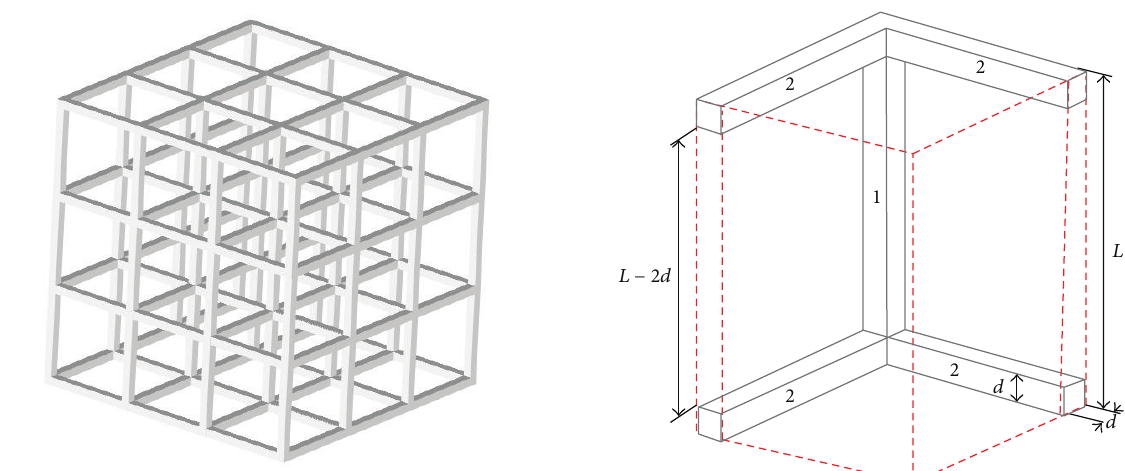
Figure 3: Simplified structure model of the open cell polyurethane foam.